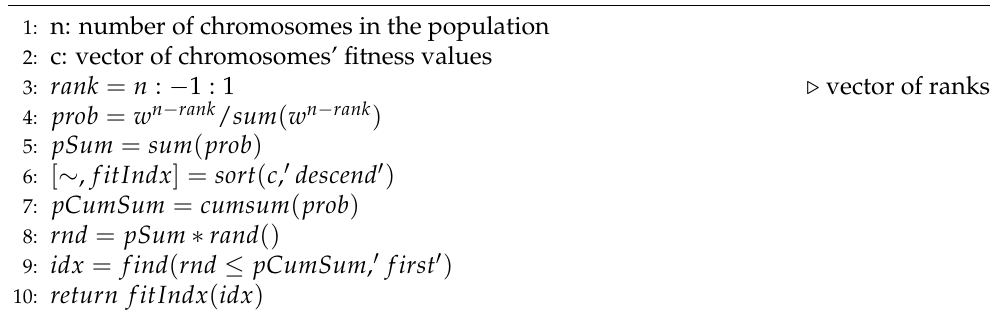
Algorithm 4 GA ERS technique.